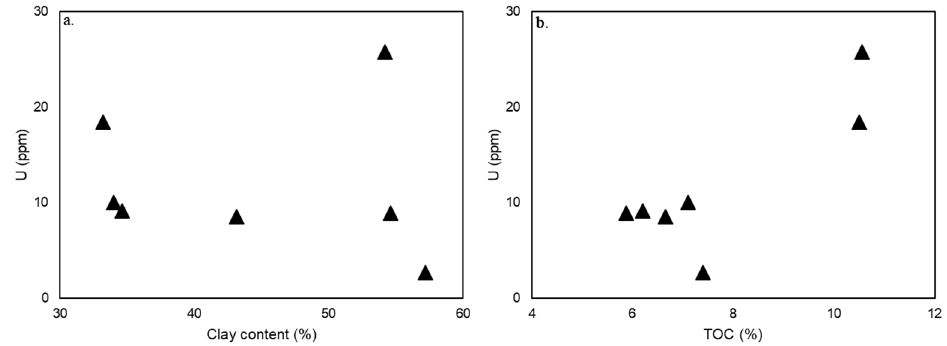
Figure 3. Point datasets from wells 15/3-8 and 17/12-4 are represented the relation between uranium versus total clay percentage ( a ) and total organic carbon ( b ).